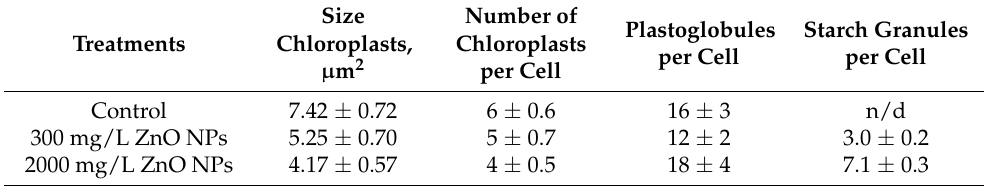
Table 3. Sizes and numbers of chloroplasts, plastoglobules, and starch granules per cell.